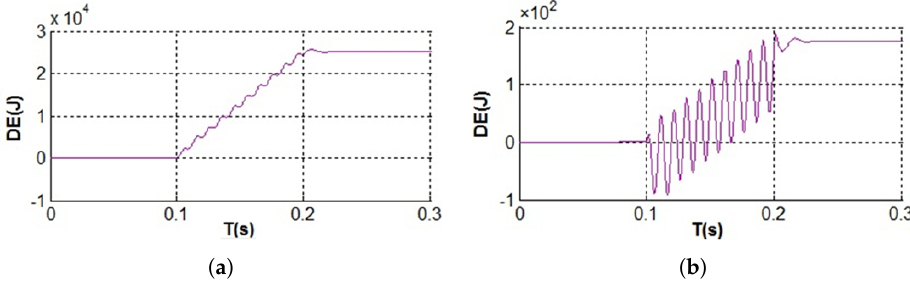
Figure 6. Effects on direction-judgments from different fluctuation characteristics. ( a ) DE signal at M 7 ; ( b ) DE signal at M 3